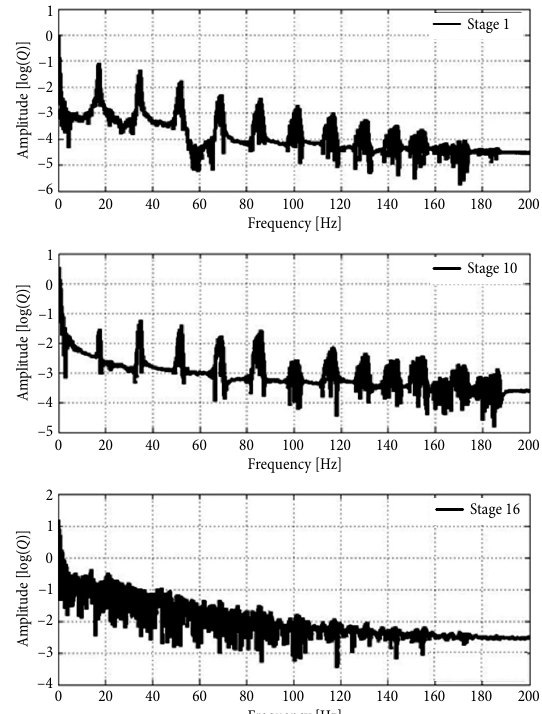
Fig. 9. Dependencies of the relative volume of gas ( ) e t in the vertical pipe at different depths when load pressure p load varies periodically: a – H = 300 m; b – H = 120 m; c – H = 30 m